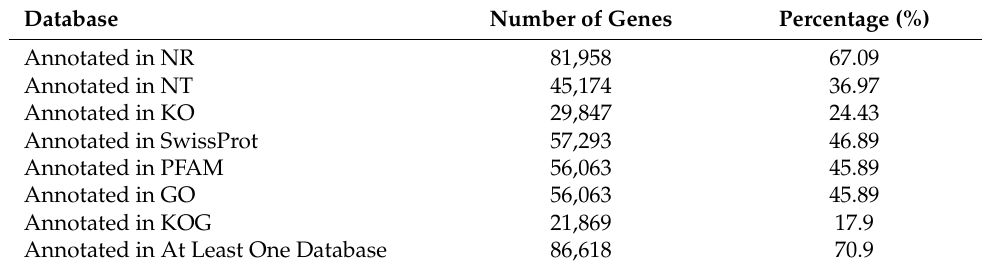
Table 2. Annotations of unigenes in various databases.